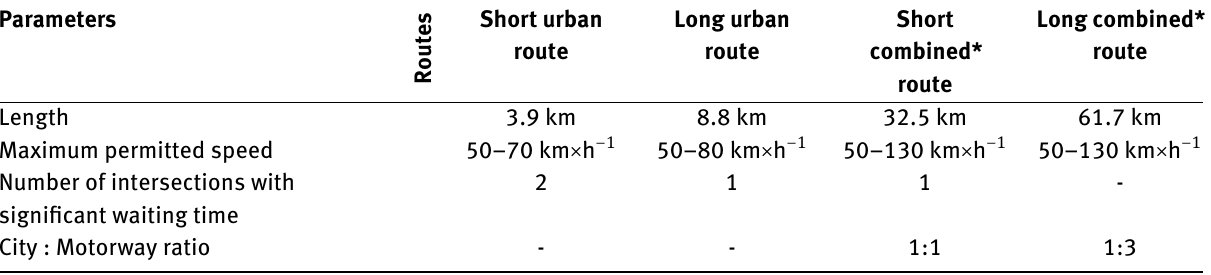
Table 2: Specifications of designated routes Parameters